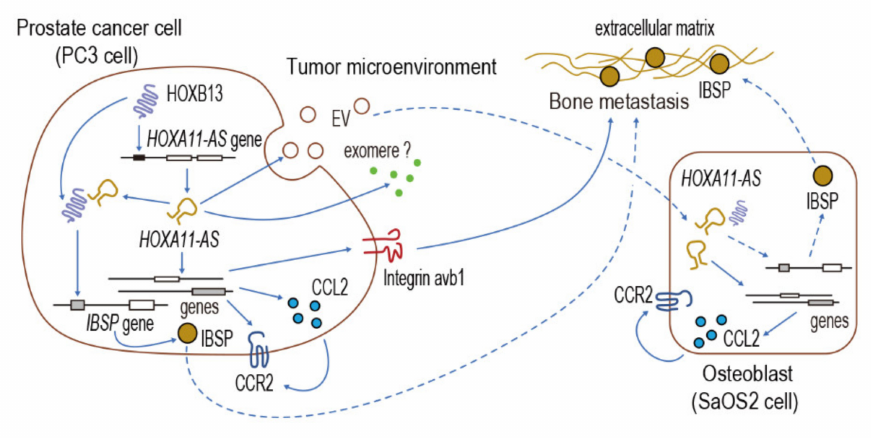
Figure 6. Working model of HOXB13 and HOXA11-AS for promotion of prostate cancer bone metastasis. HOXB13/ HOXA11-AS axis regulates integrin and CCL2/CCR2 cytokine signaling in prostate cancer cells, while paracrine action of HOXA11-AS -secreted from prostate cancer PC3 cells is able to modulate CCL2/CCR2 cytokine signaling in osteoblasts within the bone marrow milieu. Supplementary Materials: The following are available online at https://www.mdpi.com/2073 -4425/12/2/182/s1, Figure S1: AR is not involved in the regulation of HOXA11-AS, Figure S2: FOXA1 is not involved in the regulation of HOXA11-AS, Figure S3: HOXB13 knockdown downregu- lates HOXA11-AS. Figure S4: HOXB13 knockdown downregulates CCR2, Figure S5: HOXB13 and HOXA11-AS knockdown modulates protein levels of integrin subunits, Figure S6: HOXB13 binding sites on MMP3 and CDH1 gene locus in prostate cancer cells, Table S1: PCR primers used for plasmid construction, Table S2. siRNAs used for gene silencing, Table S3. PCR primers used for qRT-PCR analysis, Table S4. Membrane associated genes commonly upregulated by HOXA11-AS and HOXB13 knockdown, Table S5. Cytokines involved in the progression of prostate cancer bone